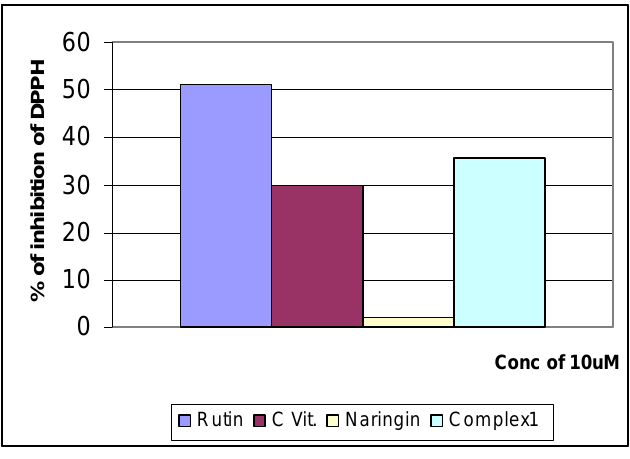
Figure 4. Inhibition of DPPH by naringin and complexes 1, whit rutin and C vitamin as control. All compounds were at the final concentration of 10 μ